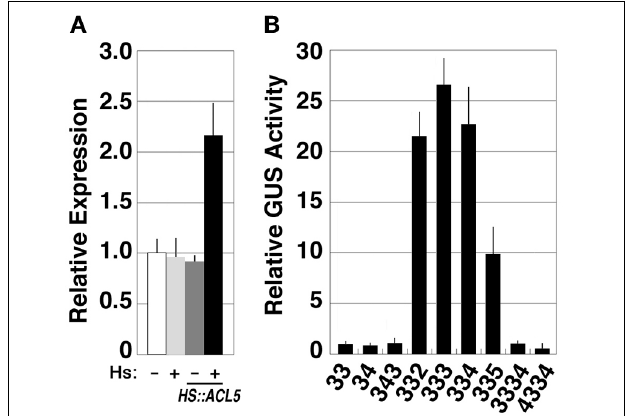
FIGURE 6 | Responses of SAC51 to polyamines in acl5-1 . (A) Effect of endogenously-induced thermospermine on SAC51 expression. Transcript levels in acl5-1 seedlings heat-shocked at 37 ◦ C for 2h followed by 24-h culture at 22 ◦ C (light gray bars), those in transgenic acl5-1 seedlings carrying the HS-ACL5 construct untreated (dark gray bars) and those heat-shocked at 37 ◦ C for 2h followed by 24-h culture at 22 ◦ C (black bars), are shown relative to those in acl5-1 seedlings untreated (white bars). (B) Effect of polyamines on SAC51-GUS expression. Transgenic acl5-1 seedlings carrying the GUS gene fused to the SAC51 promoter and its 5 (cid:2) leader sequence were grown for 7 days in MS solutions supplemented with each polyamine. Numbers correspond to those of the carbon shown in Table 1 . The activity is shown relative to that of mock-treated seedlings. Error bars represent the SE ( n = 3).